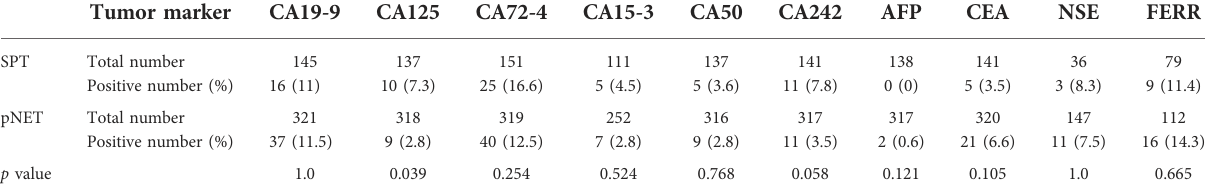
TABLE 2 Serum tumor markers of pNET and